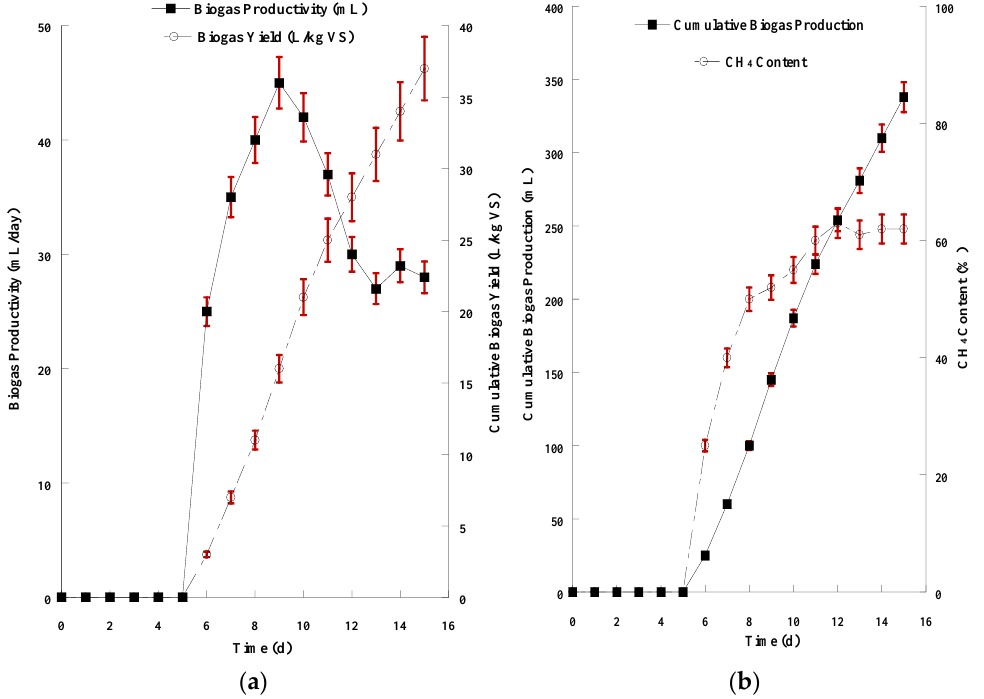
Figure 5. ( a ) Graphical representation of biogas productivity (mL/d) and biogas yield (L/kg VS) resulted from the anaerobic digestion of SMS alkaline hydrolysate; ( b ) Graphical representation of cumulative biogas production (mL) and CH 4 content of the biogas resulted from the anaerobic di- gestion of SMS alkaline hydrolysate. The presented results are the mean of two independent diges- tions.